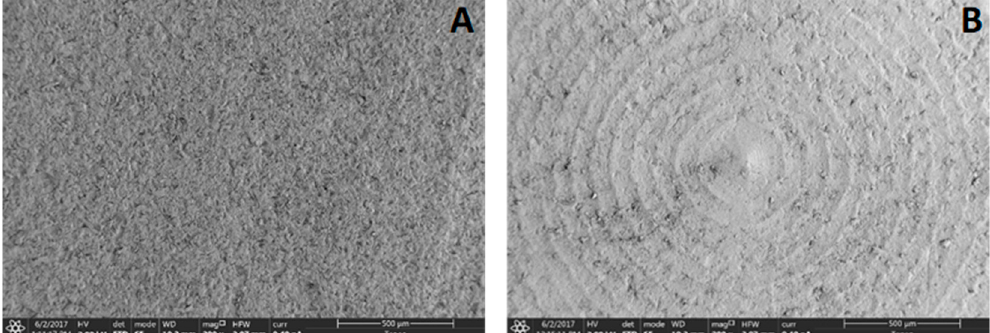
Figure 4. Scanning electron microscopy (SEM) images at 200× magnification of ZLS ( A ) and Y-TZP ( B ).